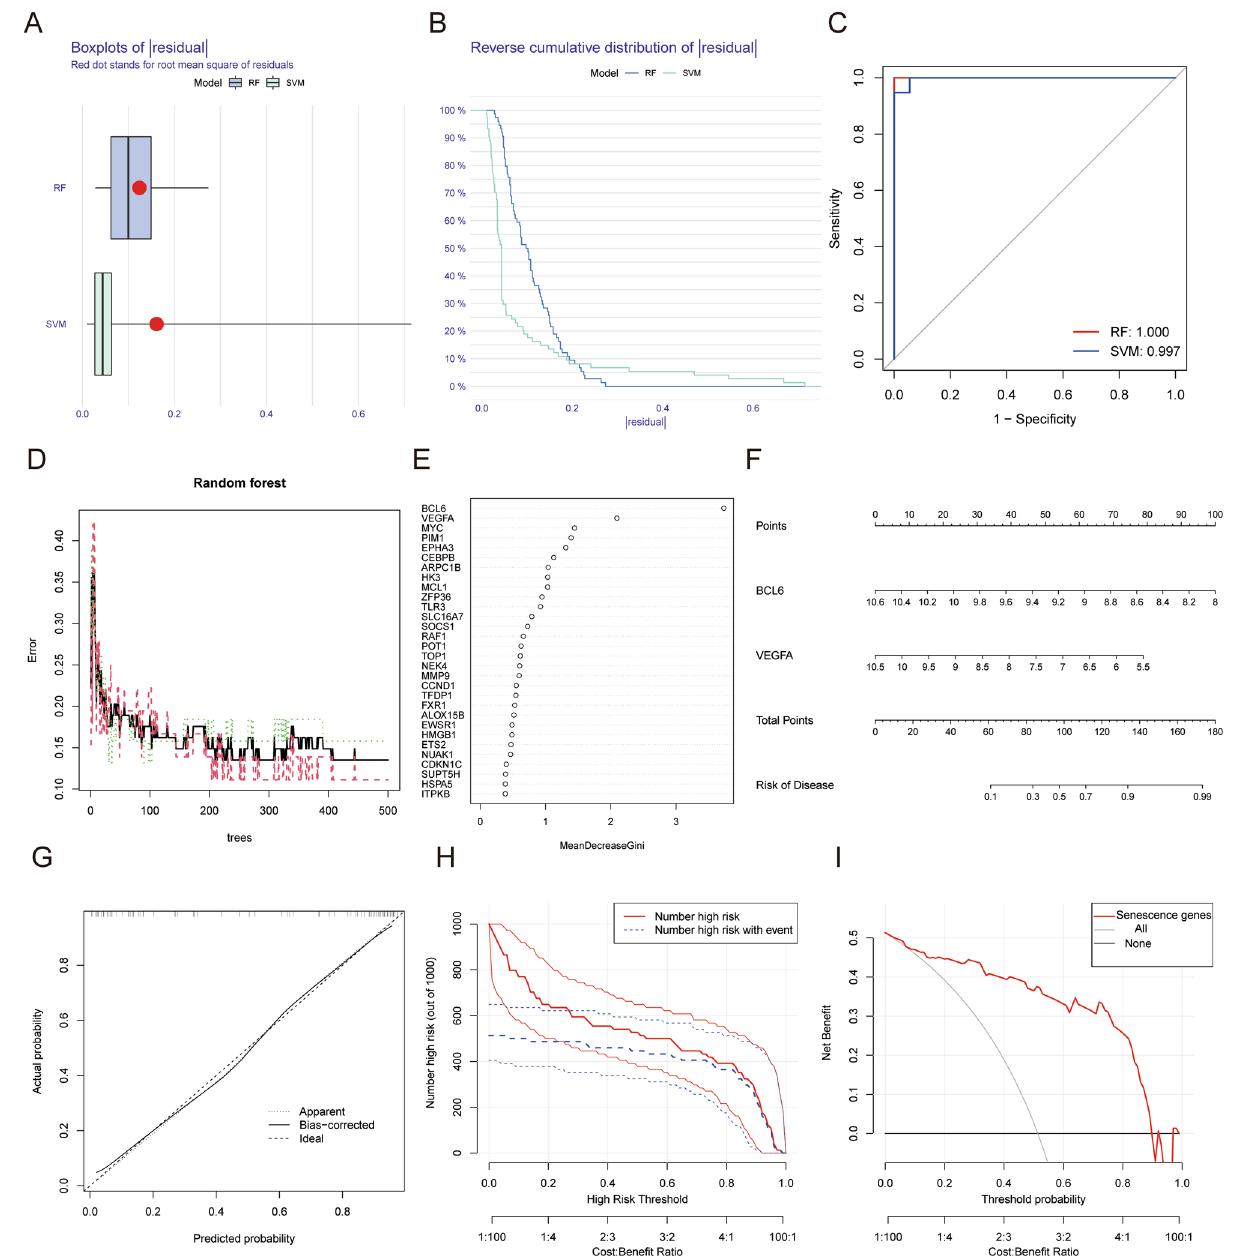
Figure 2. Construction of OA risk predictive model using the SVM and RF methods. Boxplot of the residual distribution ( A ) and reverse cumulative distribution of residual ( B ) as a function of the values and ROC curves ( C ) showing the observed sensitivity between RF and SVM. ( D ) RF: prediction error curves based on tenfold cross-validation. ( E ) The importance of the 30 senescence regulators based on the RF model. ( F ) Nomogram graph of the predictive model based on two m6A regulators. The calibration curves ( G ), clinical impact plot ( H ) and DCA ( I ) were used to determine the clinical utility of risk prediction nomograms. SVM, support vector machine; RF, random forest; OA, osteoarthritis; ROC, receiver operating characteristic; DCA, decision curve